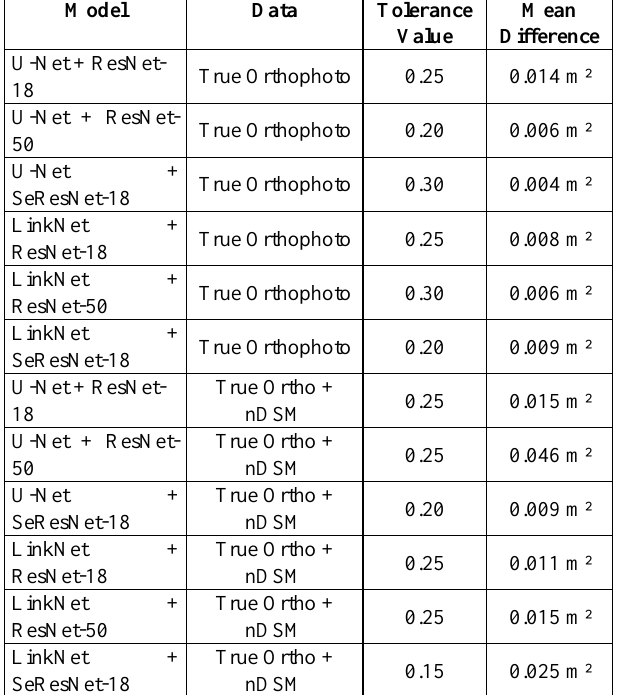
Table 4. Tolerance values used in the vectorization process and the mean difference values obtained from the predictions of the DL methods.